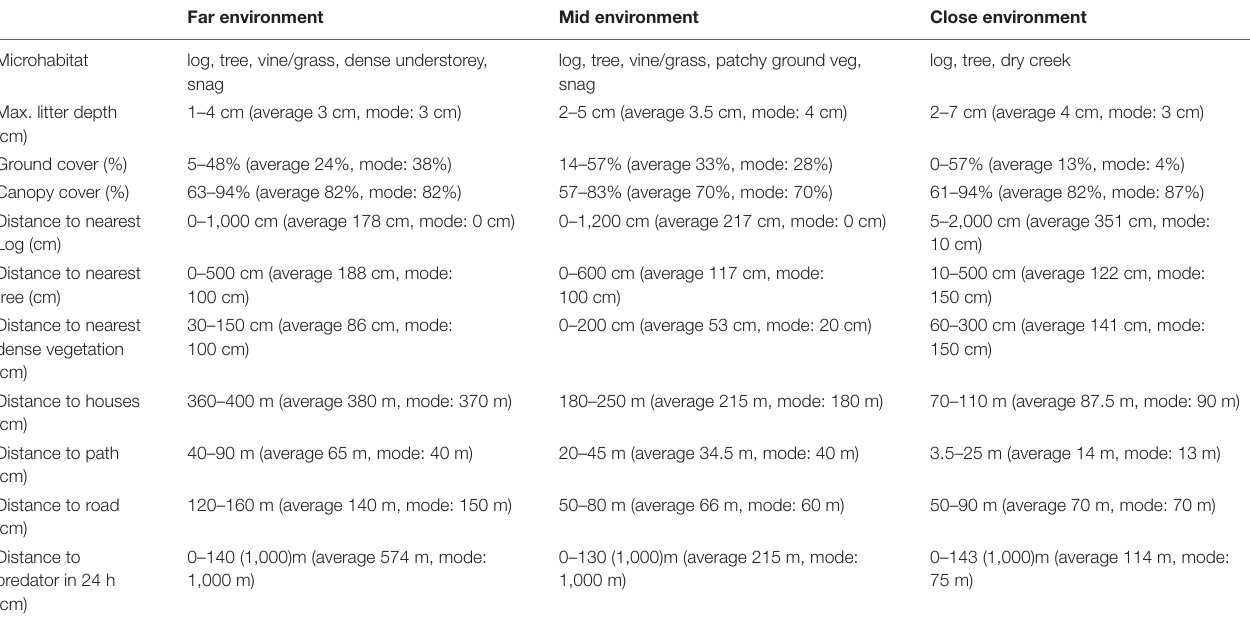
TABLE 1 | Summary of the habitat component and distances to human disturbances and predator measurements, taken across three locations (“close environment,” “mid environment,” and “far environment”) along an urban disturbance gradient. The range (lowest to highest measurements), average, and mode (the value that appeared most often in the collected data) are given for each of the variables measured. The 1,000 m measurement given for the distance to predator was repeatedly recorded for 24 h periods in which a predator was not sighted in range of a GUD station at that environment. Therefore, the ranges outside of this measurement are given with this maximum in parentheses. The mid and far environments, with mode of 1,000 m for distance to predators, indicates that more often than not no predators where sighted within range of the GUD stations in these